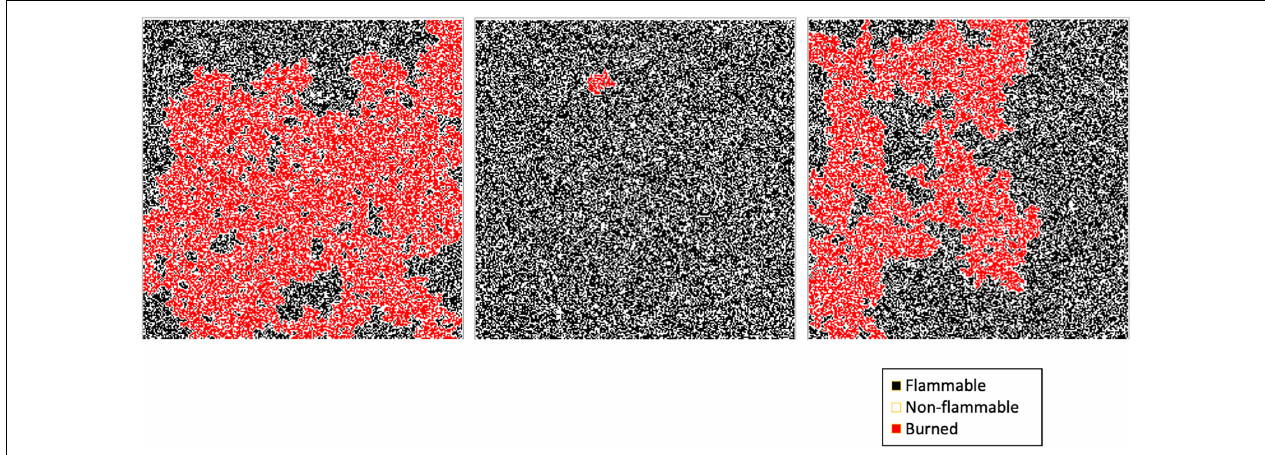
FIGURE 3 | Three replicates of random-point ignition in 250 × 250 cell binary landscapes with fixed values of p cell = 0.60 and p spread = 1.00.